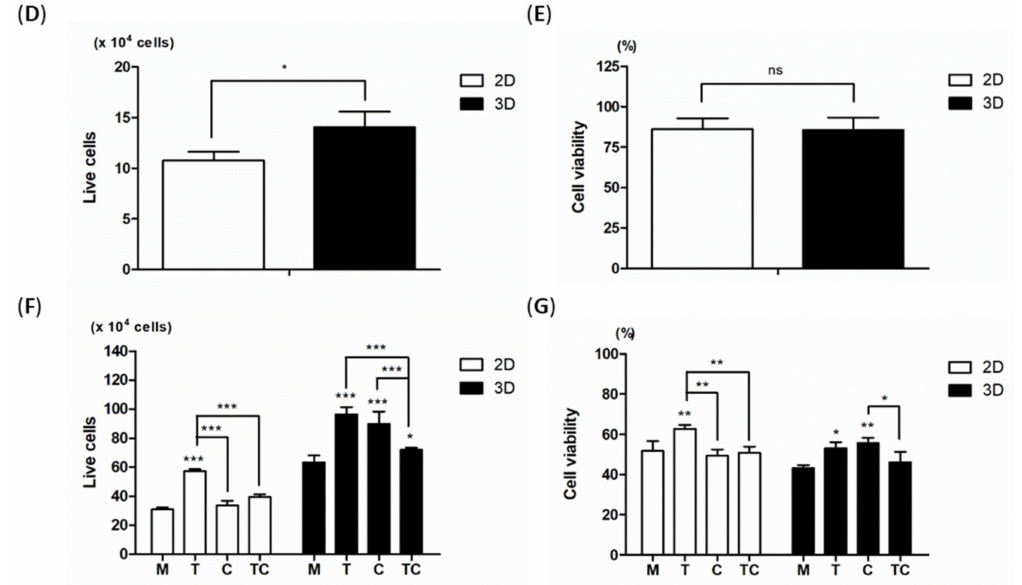
Figure 2. Effects of growth factors and culture environments on cell proliferation rates and viability during different stages of chondrogenic differentiation. ( A ) Morphology of iPS-OSH colonies grown on feeder cells. ( B ) Morphologies of chondrogenic cell cultures grown in 2D and 3D cultures at the end of stage 1, and ( C ) at the end of stage 2. ( D ) Effects of culture environments on cell proliferation, and ( E ) cell viability, at the end of stage 1. ( F ) The effects of growth factors and culture conditions on cell proliferation, and ( G ) cell viability, at the end of stage 2. The number of viable cells and cell viability were determined using trypan blue exclusion assay (M: mock; T: Tgfb1; C: Csf3; TC: Tgfb1 and Csf3). Bars represent mean and SD. Difference between groups were evaluated by two-tailed Student’s t test or one-way analysis of variance with Newman-Keuls Multiple Comparison Test (* p = 0.01–0.05; ** p = 0.001–0.01; *** p < 0.001, ns: no statistically significant